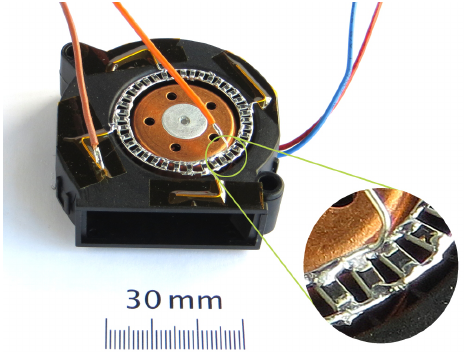
Figure 2. Fan and heating element used to stabilise temperature in- side COCAP. The heating element is made of surface-mount tech- nology resistors soldered to two concentric rings of wire. It is lo- cated just above the air inlet of the radial